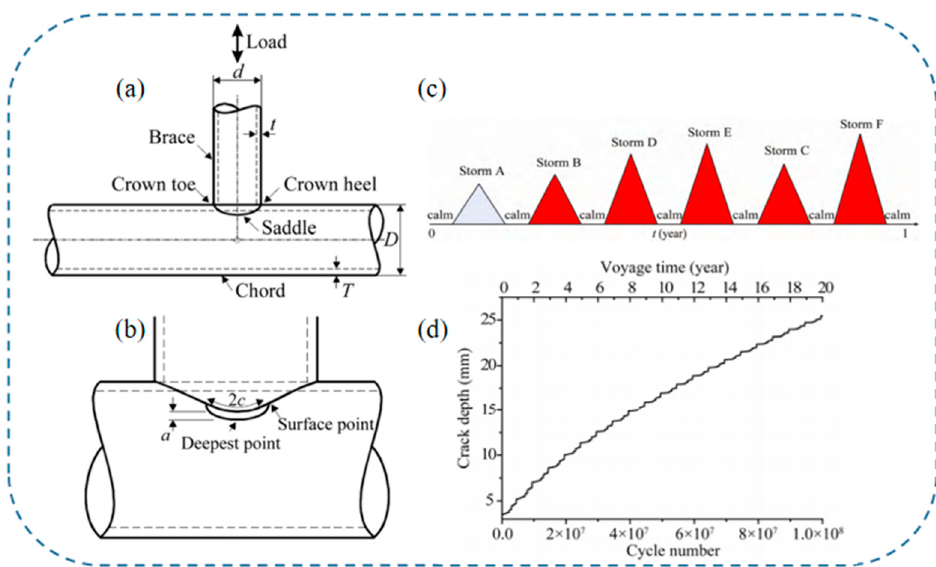
Figure 8. ( a ) A typical tubular T-joint under brace tension; ( b ) a surface crack initiated from the saddle position of the T-joint; ( c ) standardized load-time history; ( d ) fatigue life prediction based on SLH and UFLP[18].